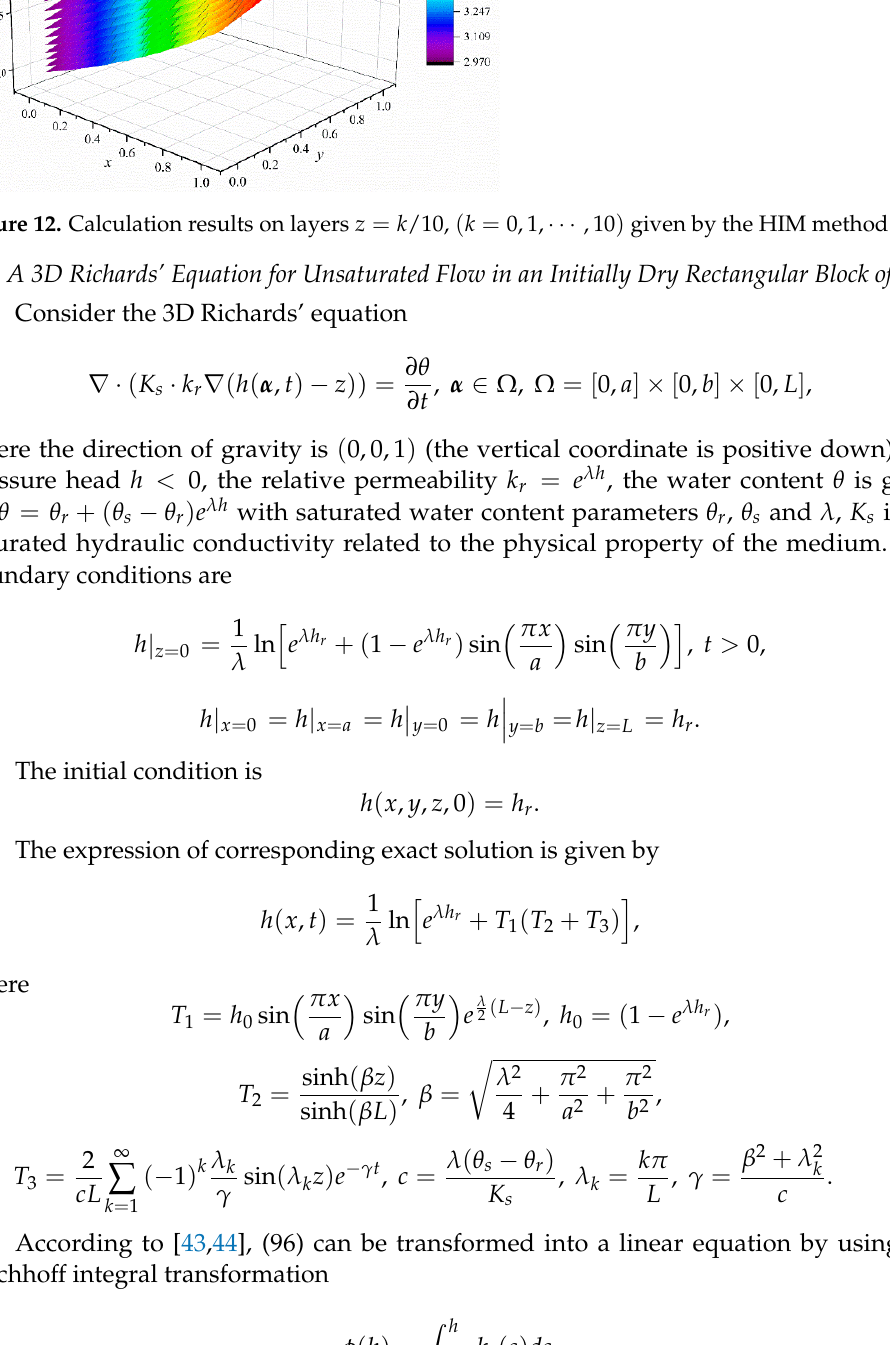
Figure 11. Calculation results along z -axis when t